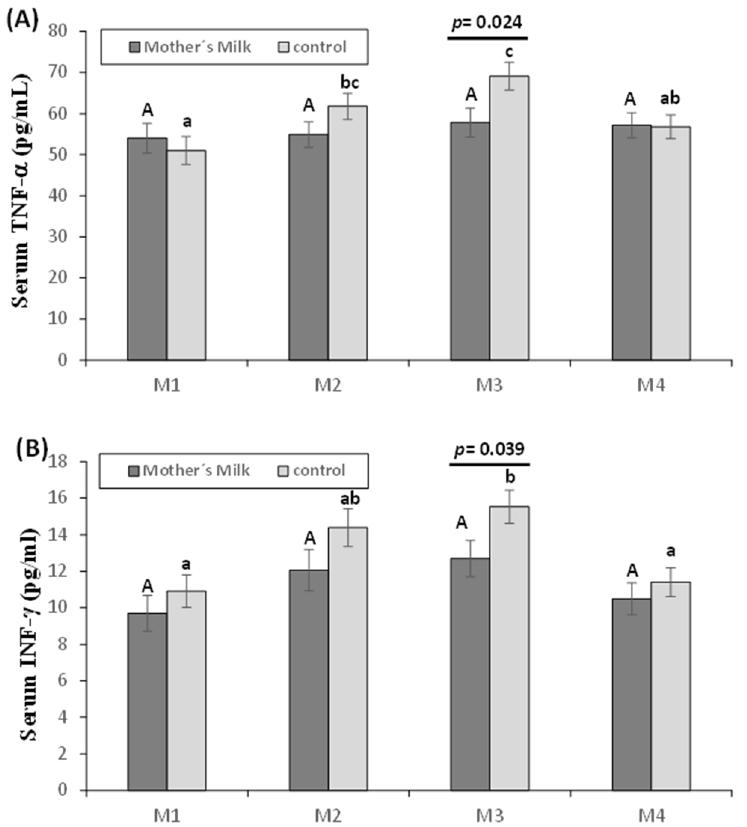
Figure 3. Effect of oropharyngeal mother’s milk administration on the levels of TNF- α ( A ) and INF- γ ( B ) in serum. Results are expressed as mean ± standard error of the mean. A line between bars means statistically significant differences between groups ( p < 0.05). Different letters in every group indicate significant differences due to the time (mother’s milk (A, B, C), control (a, b, c) ( p < 0.05)). M1: Birth (basal value), M2: 3rd day of postnatal life, M3: 15th day of postnatal life, M4: 30th day of postnatal life.